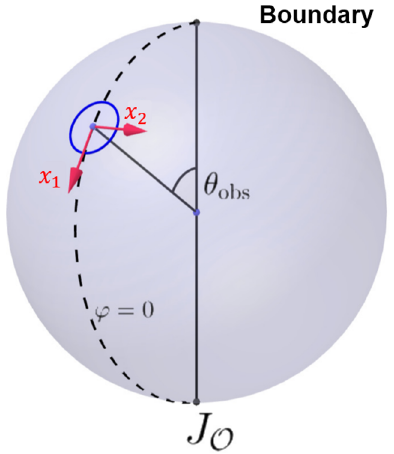
Figure 1 . The observation region is surrounded by the blue circle on the boundary unit